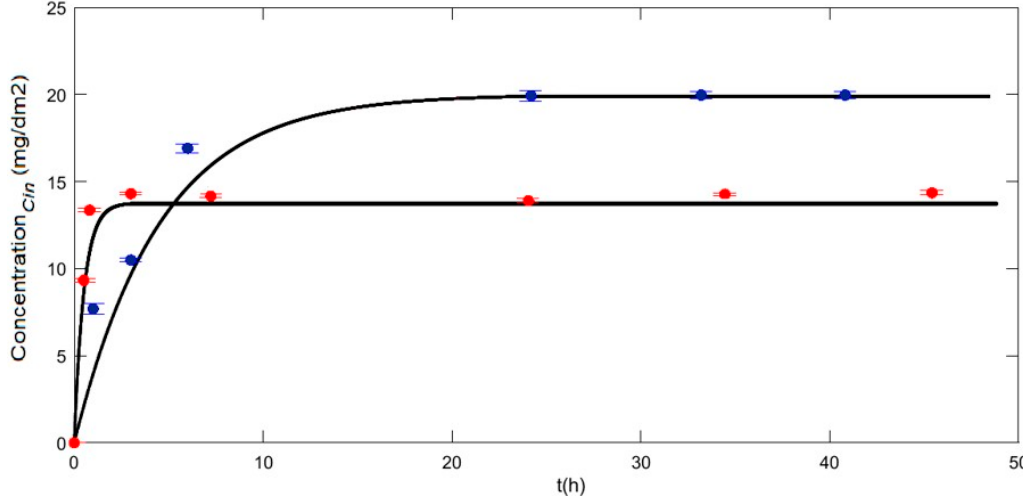
Figure 6. Release kinetic of cinnamaldehyde from e- PLA/CIN imp ( blue dots ) and e- PLA-CIN ( red dots ) in EtOH 50%, as a food simulant, at 40 °C.